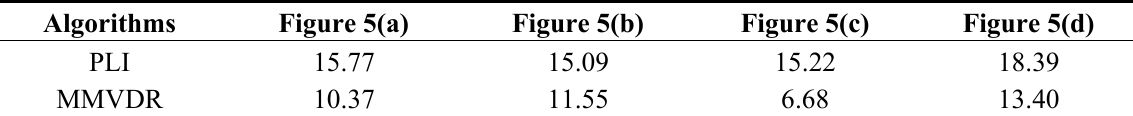
Table 4. Image errors